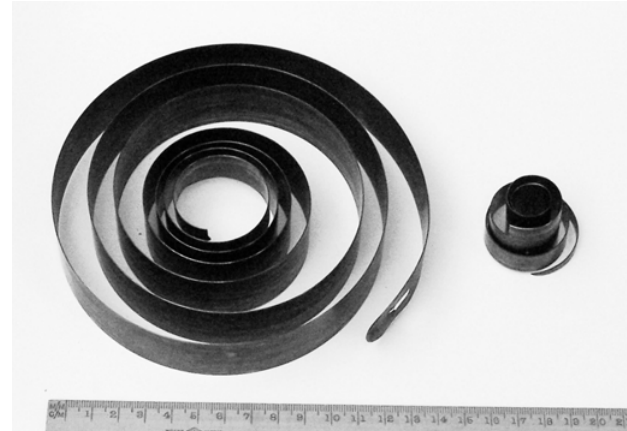
Figure 9. Wall clock by John Davidson, Coatbridge.